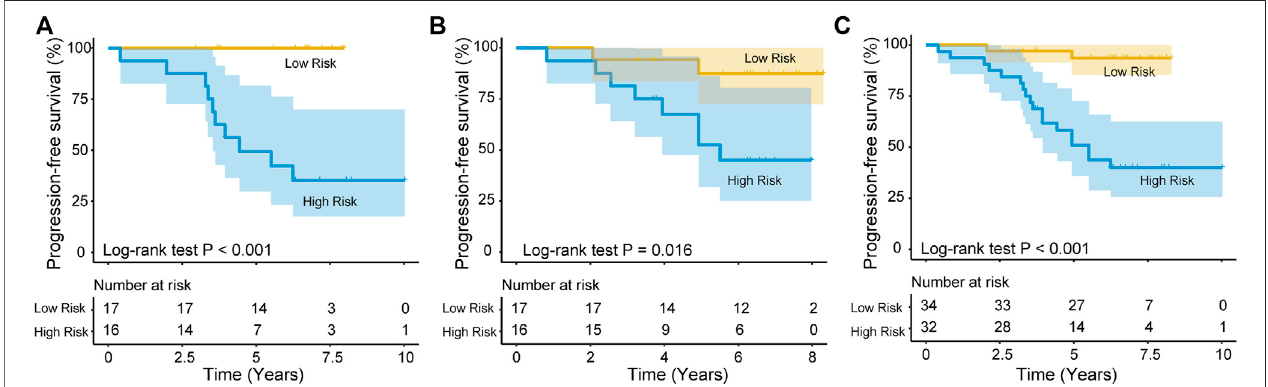
FIGURE 3 | The lncRNA signature for predicting recurrence PFS of patients with NFPA. Kaplan – Meier survival curves of patients classi fi ed into high- and low-risk groups using the lncRNA signature in the training (A) , test (B) and entire dataset (C) .